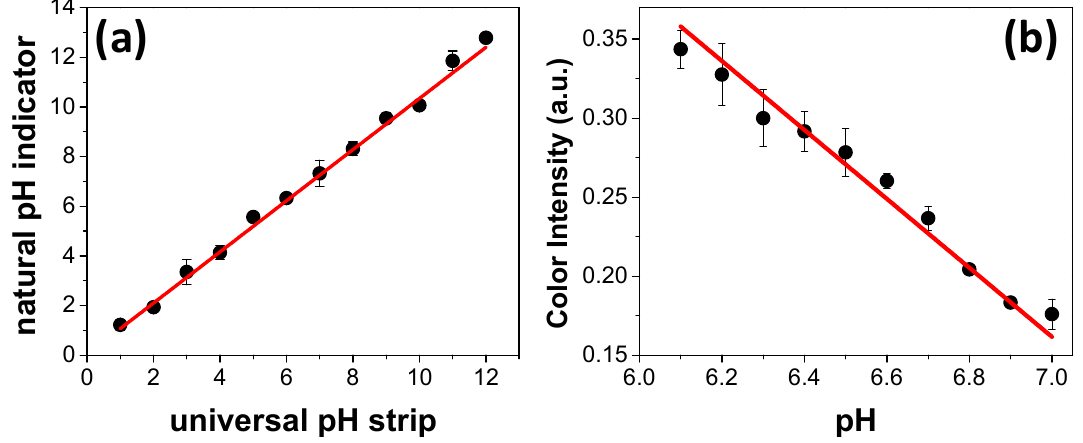
Figure 3. Presentation of ( a ) pH values measured with universal pH strip and wax printed paper zones previously spotted with natural pH indicator and ( b ) pH resolution measured on paper zones. In (a), all measurements were recorded for standard solutions prepared in a pH range between 1 and 12.